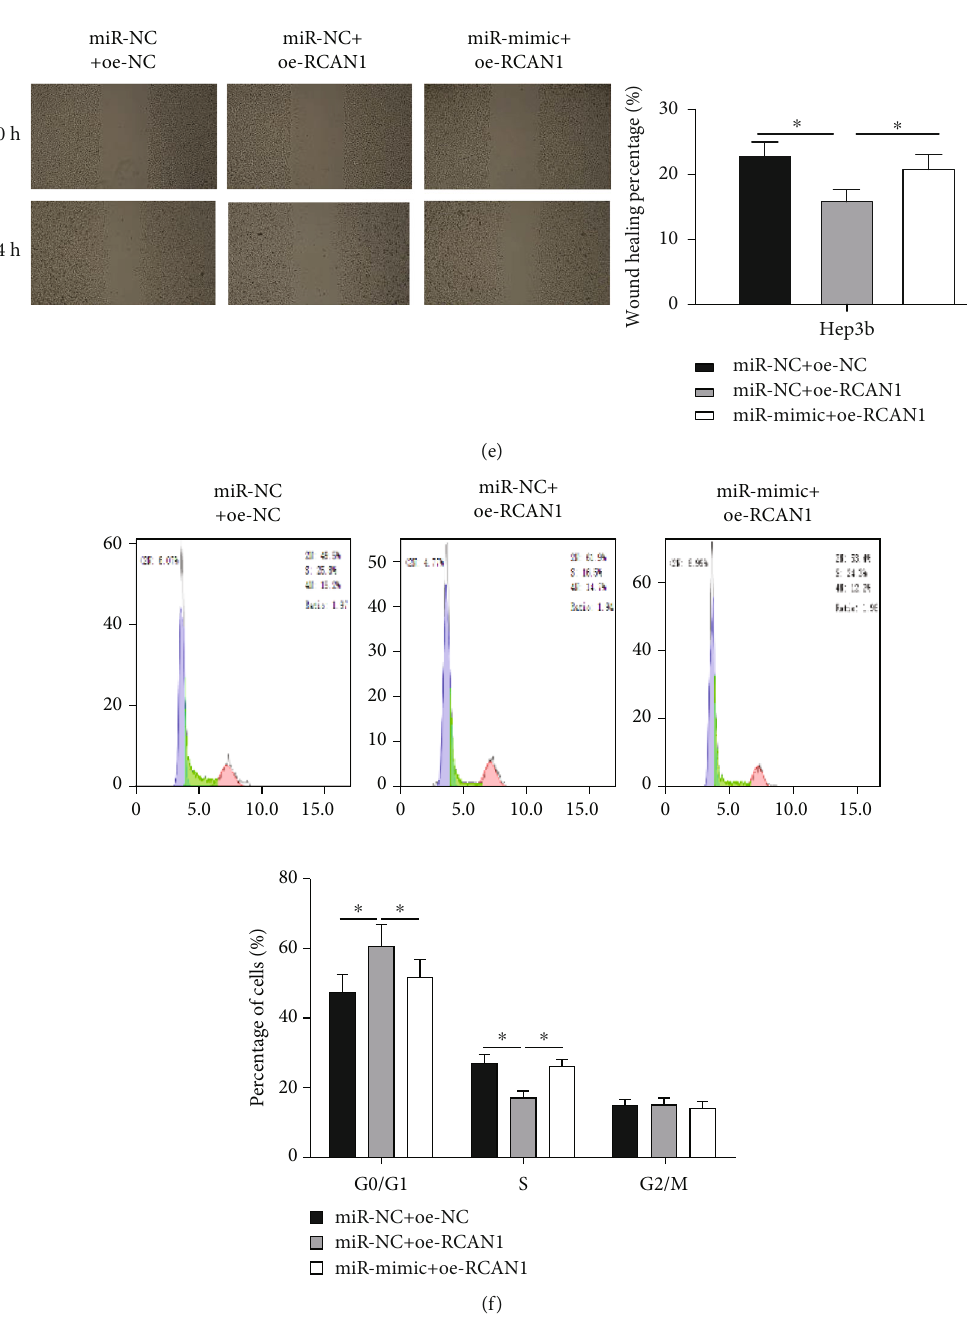
Figure 5: miR-182-5p promotes cell progression of liver cancer via targeting RCAN1. (a) The expression levels of RCAN1 mRNA in Hep3b cells in di ff erent transfection groups ( miR − NC + oe − NC , miR − NC + oe − RCAN1 , and miR − mimic + oe − RCAN1 ) were detected by qRT-PCR; (b) the protein expression of RCAN1 in Hep3b cells in di ff erent transfection groups was assessed through western blot; (c) the proliferative ability of Hep3b cells in di ff erent transfection groups was measured via CCK-8 assay; (d) the invasive ability of Hep3b cells in di ff erent transfection groups was measured by Transwell assay (100 × ); (e) the migratory ability of Hep3b cells in di ff erent transfection groups was assessed via wound healing assay (40 × ); (f) changes of Hep3b cell cycle in di ff erent transfection groups were tested by fl ow cytometry; ∗ p < 0 : 05